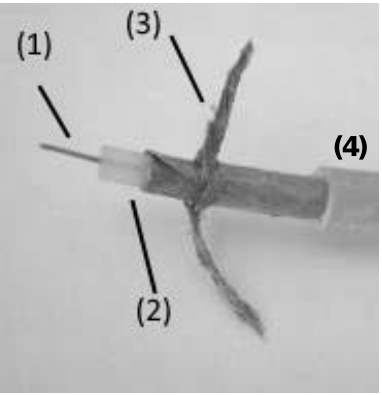
Figure 1. Morphology of the analyzed coaxial cables.